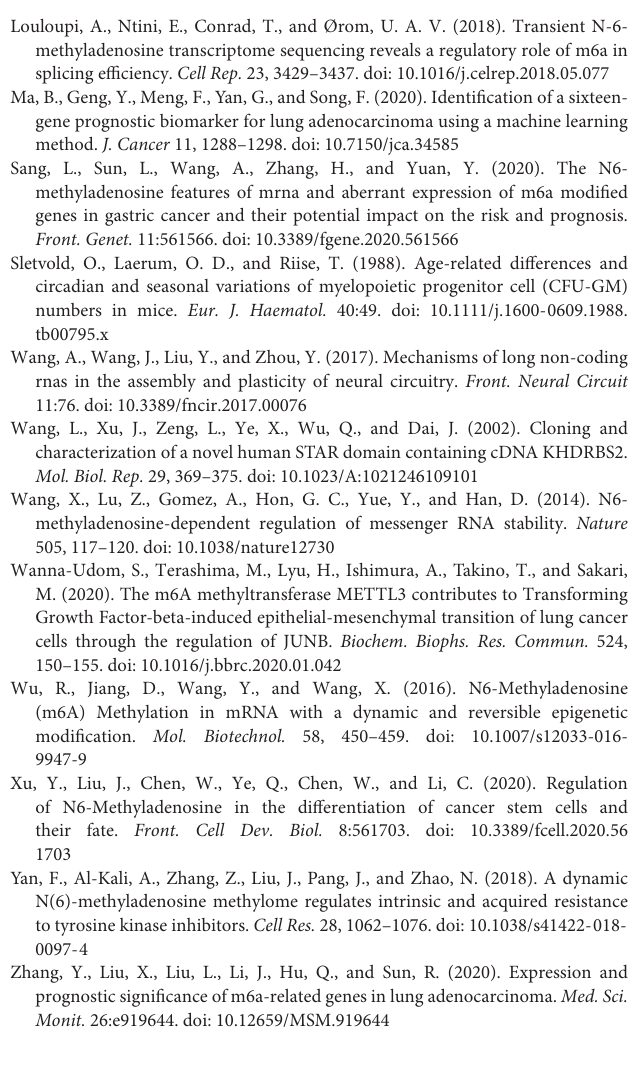
Supplementary Figure 1 | (A) The expression levels of six selected mRNAs in six paired LUAD patient tumor tissues (Tumor) and matched adjacent non-tumor tissues (Normal). (B) The m6A methylation level of six selected mRNAs in six paired LUAD patient tumor tissues (Tumor) and matched adjacent normal tissues (Normal). Supplementary Figure 2 | The mRNA expression level of RFXAP (A) and KHDRBS2 (B) in GEPIA